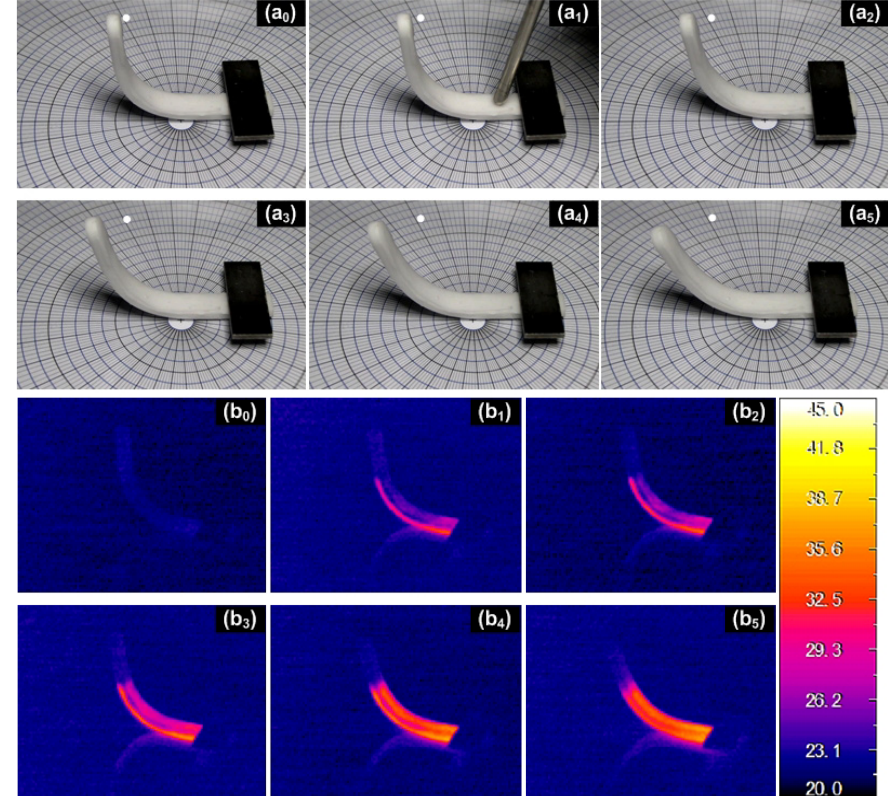
Figure 23. Optical ( a ) and infrared ( b ) snapshots of shape recovery sequence in a piece of silicone–PW–CH COONa·3H O hybrid triggered by gently tapping once at a local point as 3 2 shown in ( a ). The unit of temperature bar in ( b ) is °C 1